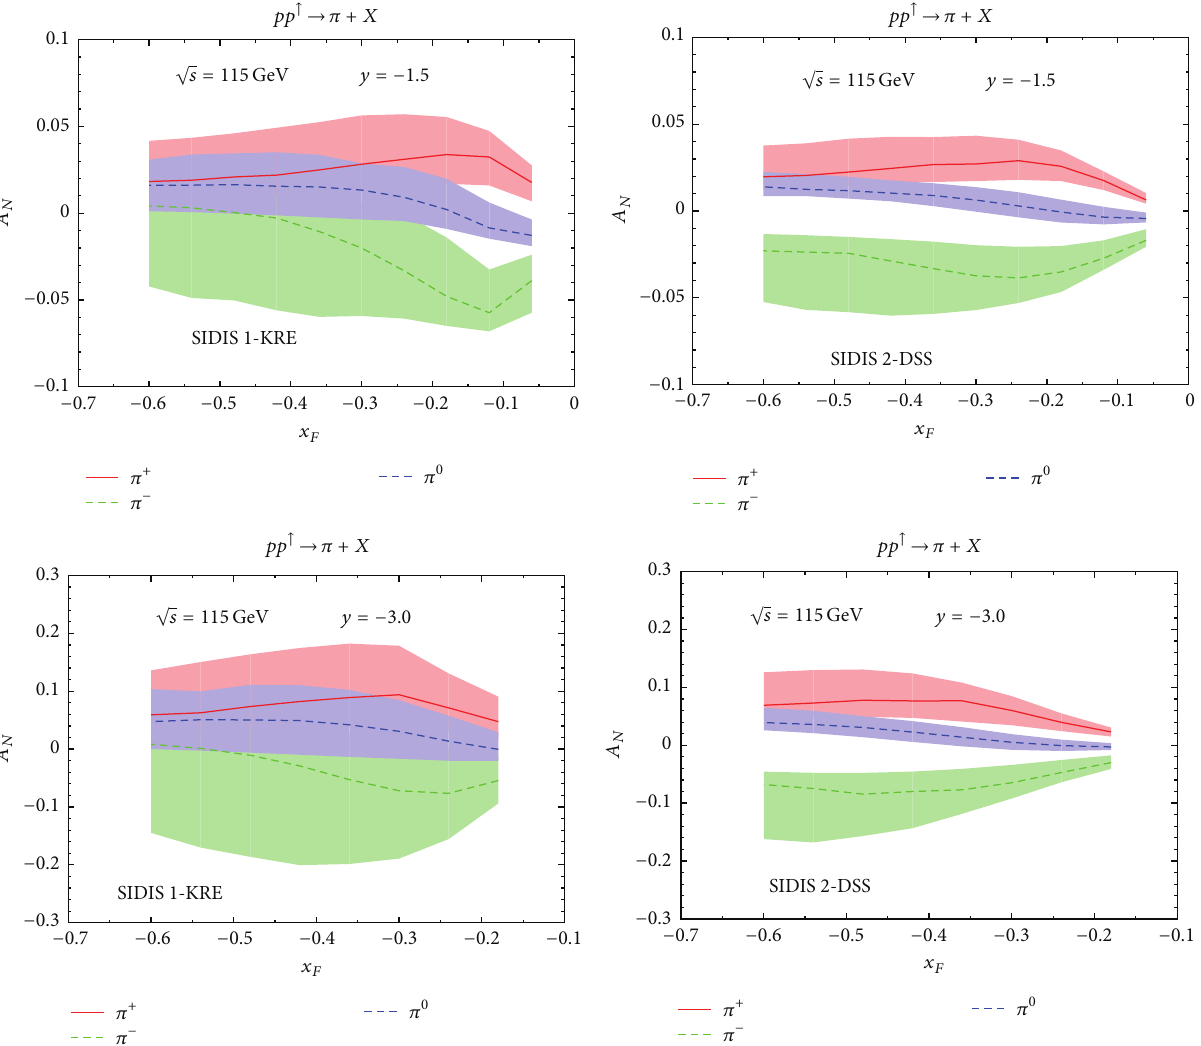
Figure 2: Our theoretical estimates for 𝐴 𝑁 versus 𝑥 𝐹 at √𝑠 = 115 GeV, 𝑦 = − 1 . 5 (upper plots), and 𝑦 = − 3 . 0 (lower plots) for inclusive 𝜋 ±